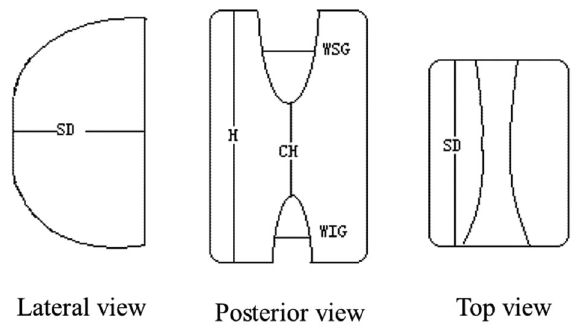
Figure 3. A proposed interspinous stabilization device for Chinese patients in lateral view, posterior view and top view. SD: sagittal diameter; H: height; CH: central height; WSG: width of the superior groove; WIG: width of the inferior